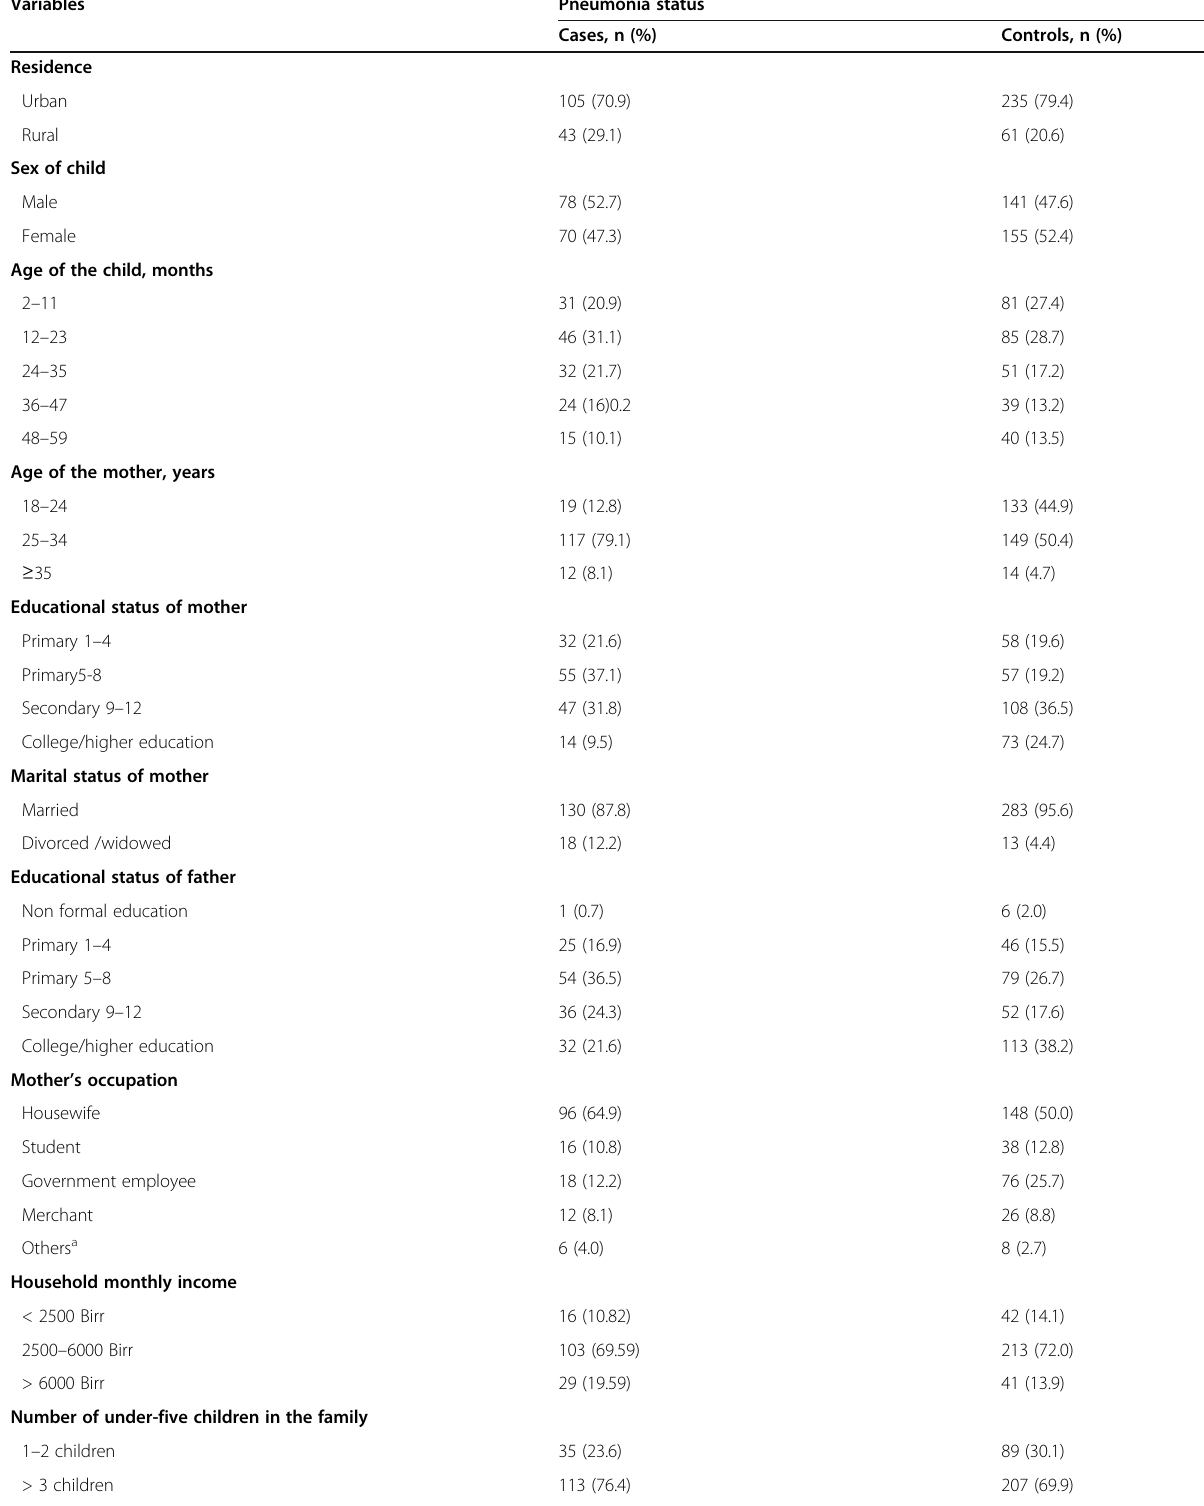
Table 1 Socio-demographic characteristics of children 2 – 59 months of age in Northeast Ethiopia,